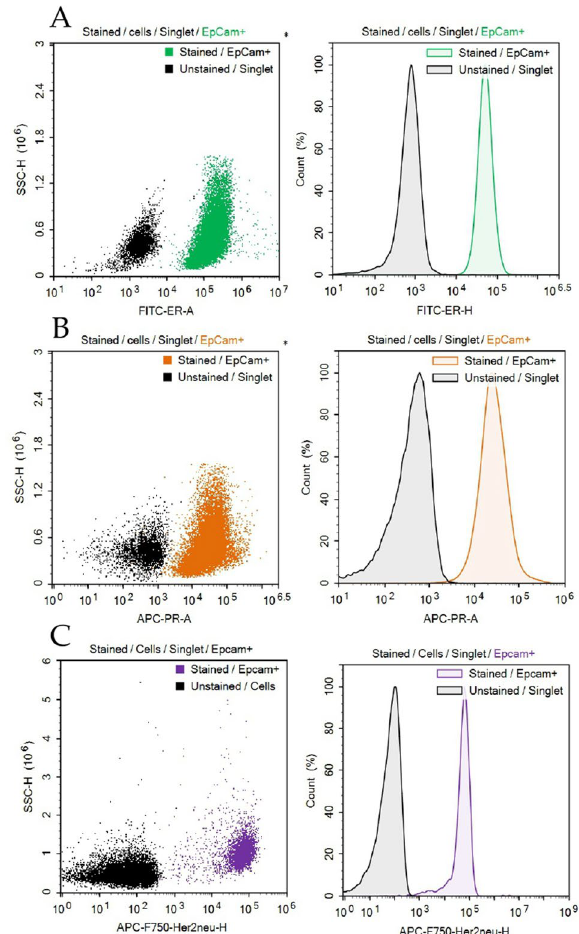
Figure 1. ( A ) Comparison between MCF-7 labeled with anti-ERα antibody and non-labeled MCF-7 cell culture; ( B ) comparison between MCF-7 labeled with anti-PR antibody and non-labeled MCF-7 cell culture; ( C ) comparison between BT-474 labeled with anti-HER2 antibody and non-labeled BT-474 cell